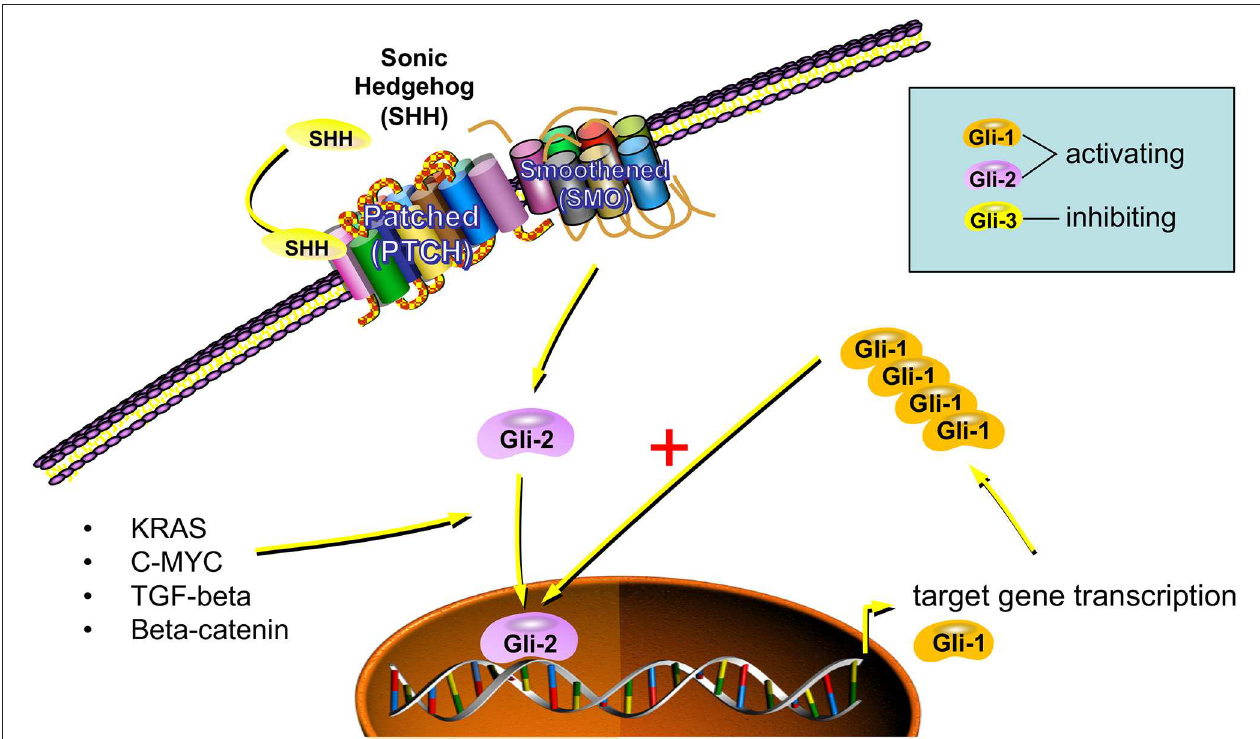
FIGURE 5 | Interpretation of increased Gli1 expression as indicator of increased hedgehog signaling. Binding of a hedgehog ligand-like sonic hedgehog (SHH) to the transmembrane receptor Patched (PTCH) leads to the dissociation of PTCH from Smoothened (SMO). Thereby signal transduction to the cytoplasm is initiated, and Gli transcription factors are translocated to the nucleus. Gli2 is the main factor responsible for the transcription of hedgehog target genes. Gli1 is one of the hedgehog target genes and its transcription is increased by hedgehog signaling. Gli1 augments the transcription activation of Gli2. In this context, Gli1 expression can be interpreted as surrogate marker of hedgehog activation. Besides the described canonical hedgehog activation through extracellular ligand-like sonic hedgehog (SHH), a noncanonical hedgehog activation via oncogenic pathways like KRAS, C-MYC, transforming growth factor beta (TGF-beta), or beta-catenin can also be observed (The figure was created using the software tool powerpathways, 2010; source: epath3d San Diego,